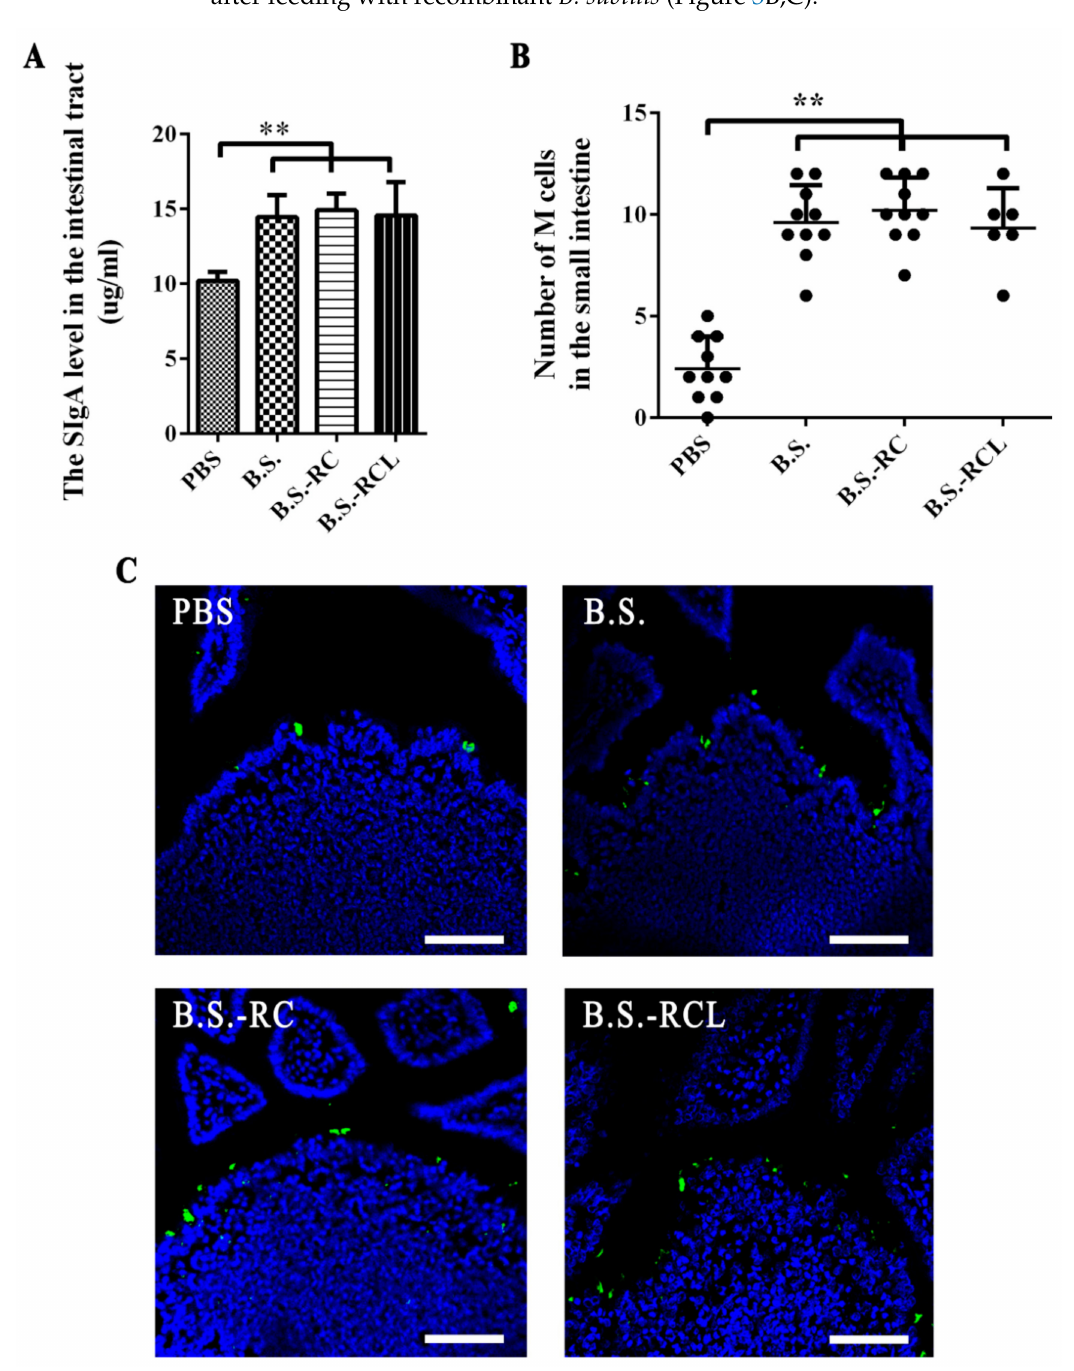
Figure 3. Analysation of the SIgA level and M cell number in the mice intestine. ( A ) The SIgA level in the mice intestine were displayed by histogram (Signifcance diference was expressed as, ** p < 0.01). Orally administrated with PBS, B. subtilis WB800N, B. subtilis RC and B. subtilis RCL at 0 and 7 days and the sample were collected at 14, 21 and 28 days. M cells were stained by UEA-1. ( B ) The number of M cells in the small intestine of each mouse was displayed. ( C ) Immunofluorescence staining results of M cells in mice small intestines (oral PBS group, oral B. subtilis WB800N group, oral B. subtilis RC group and oral B. subtilis RCL group. Scale bars = 50 µ